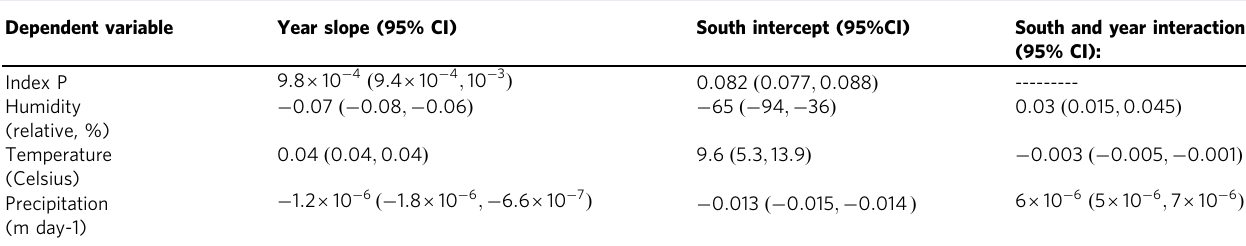
Table 2 Statistical output from the linear quantile mixed